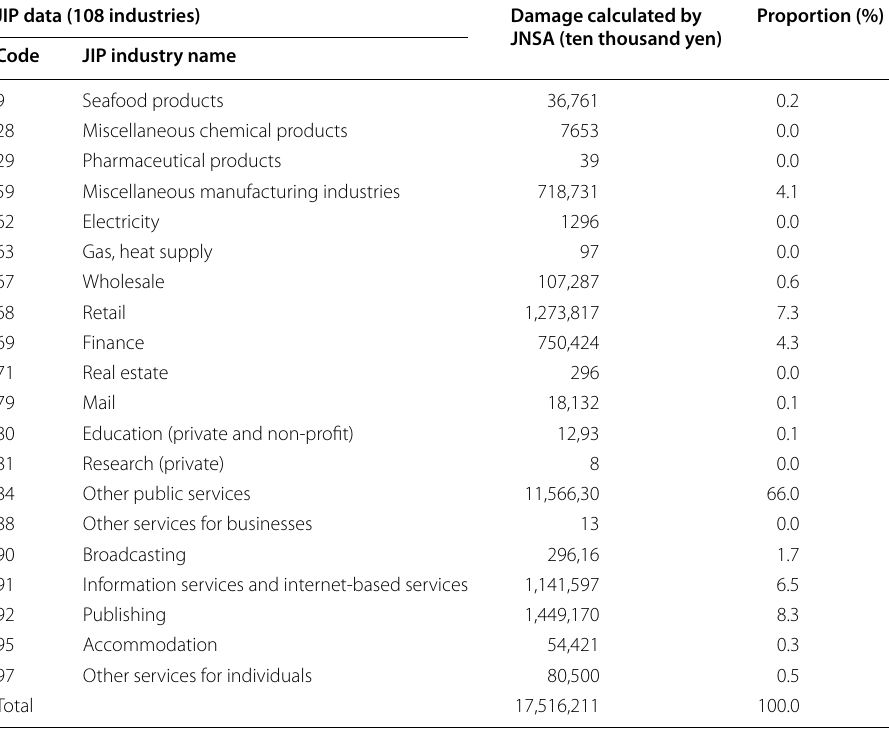
Source: Created by the authors based on JNSA